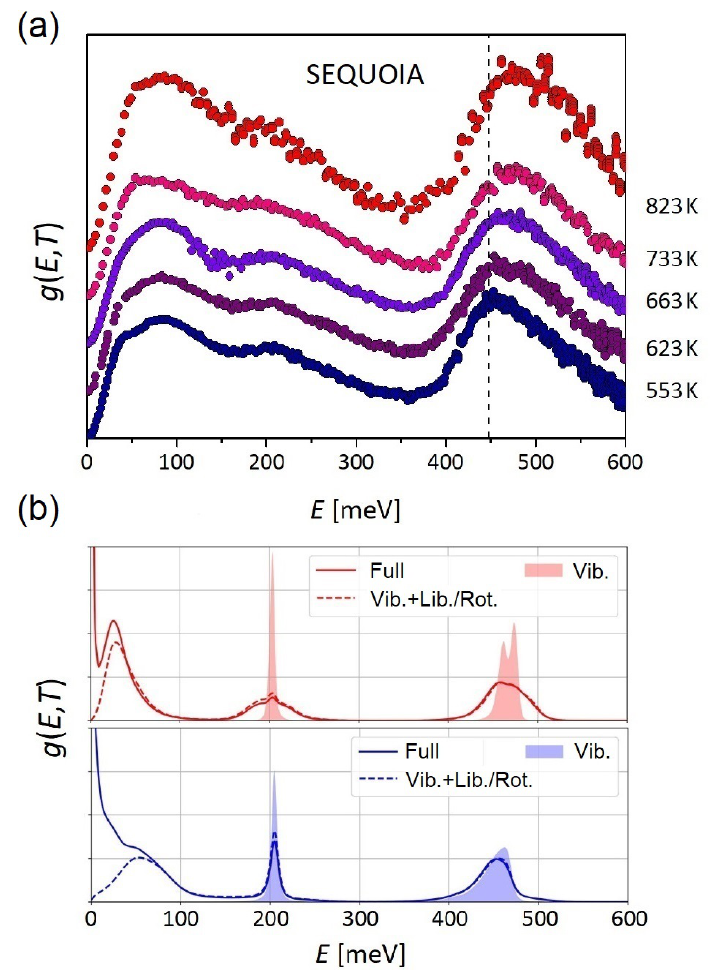
Figure 12. ( a ) Hydrogen-projected VDOSs as a function of temperature at a pressure of 0.025 GPa. These data have been normalized to unity and vertically offset to facilitate visual comparison. ( b ) Simulated VDOSs of H 2 O at subcritical (bottom) and supercritical (top) conditions. In each case, the full spectrum (solid line) is compared with the projected VDOS (dashed line), after removing translational contributions. The shaded spectra correspond to intramolecular vibrational spectra, with librational and rotational motions projected out. Adapted with permission from Ref. [332]. Copyright (2021) American Chemical